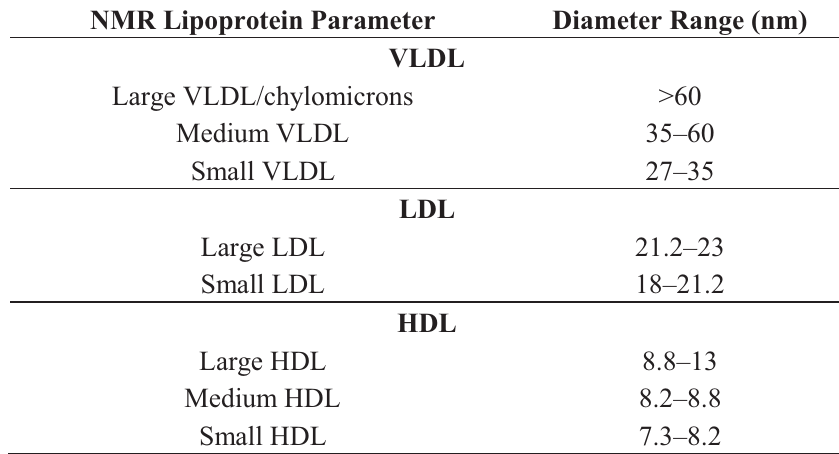
Table 1. Diameter ranges of lipoprotein subclasses when measured by Nuclear Magnetic Resonance Spectroscopy